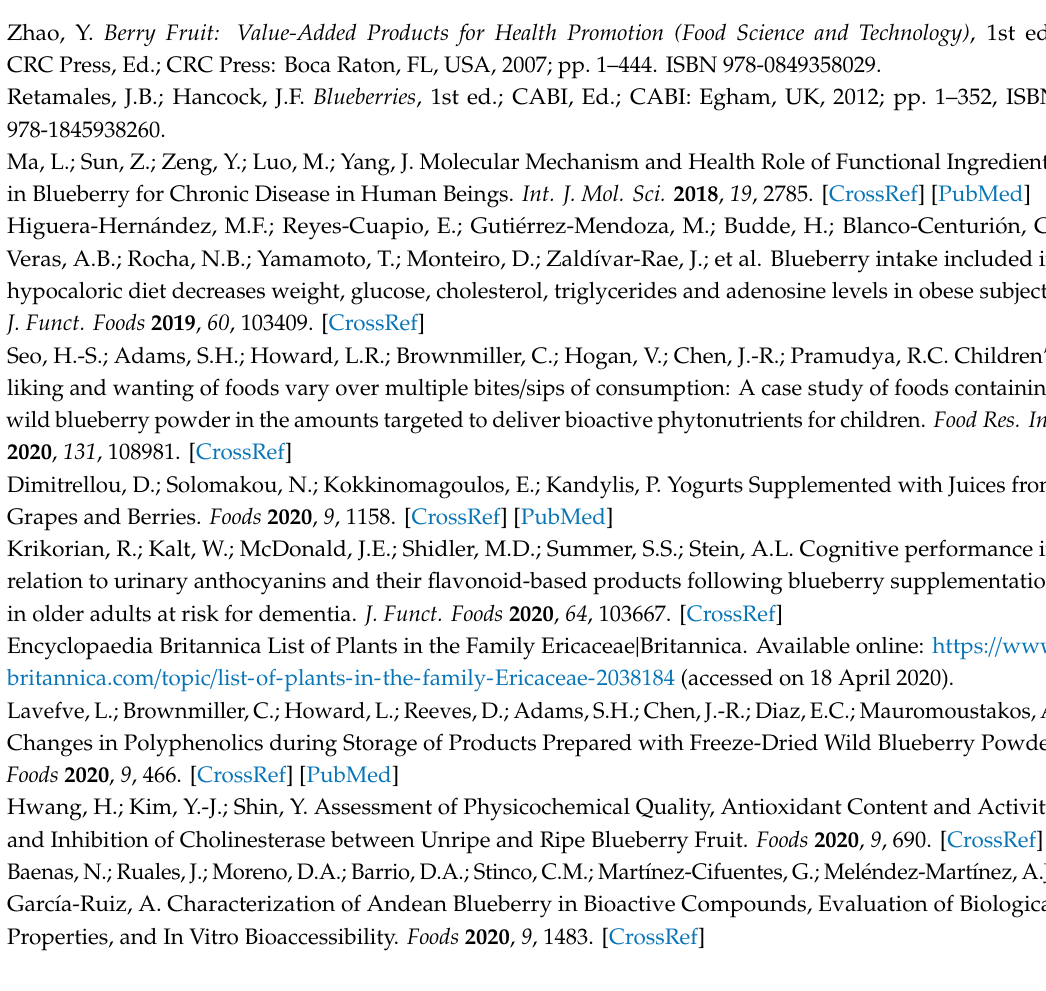
Table S1. Box–Behnken design matrix with the values of the six variables for each experiment and measured and predicted responses ( n =